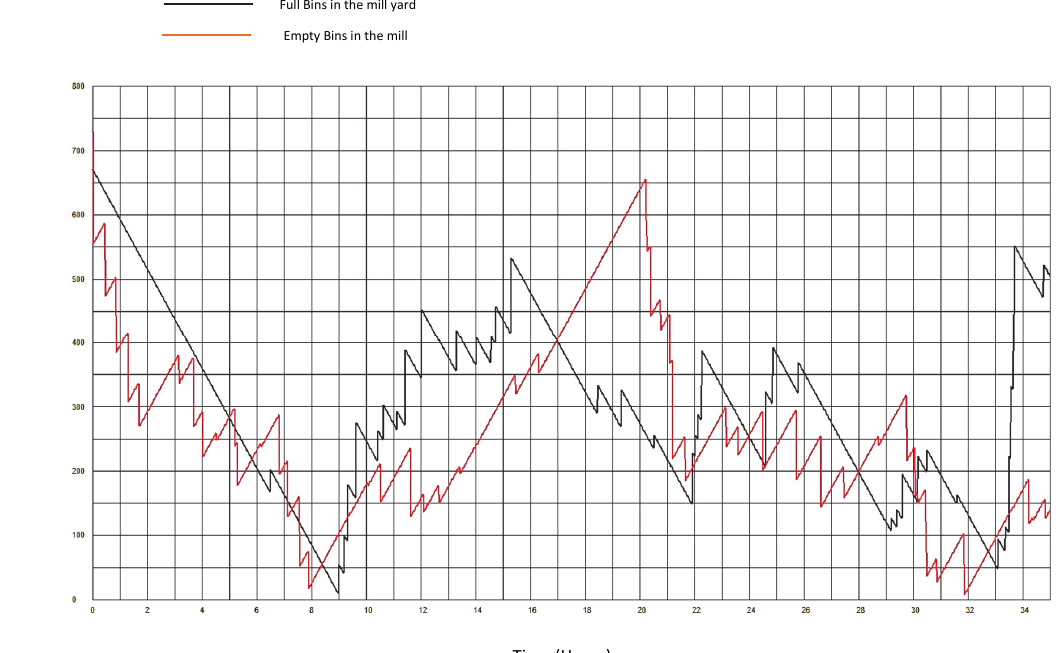
Fig. 8. Empty and full bins at Mill in the first